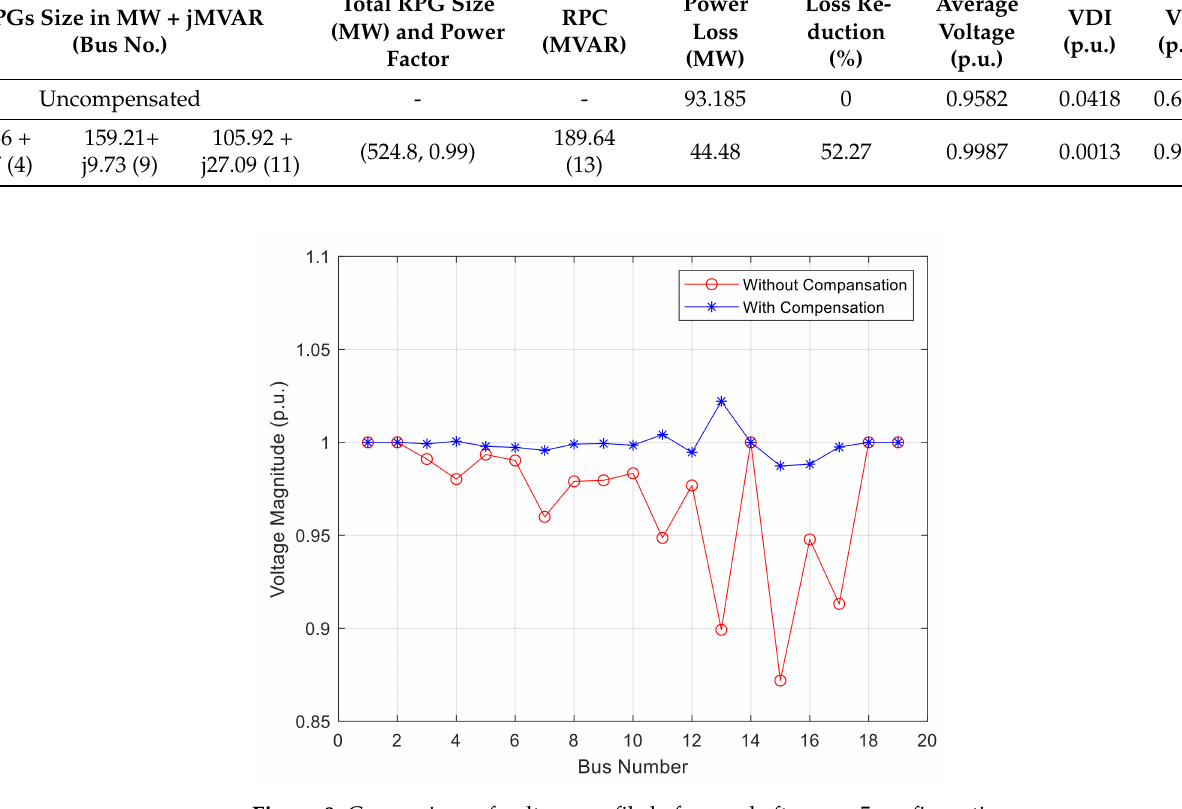
Figure 9. Comparison of voltage profile before and after case 5 configuration.